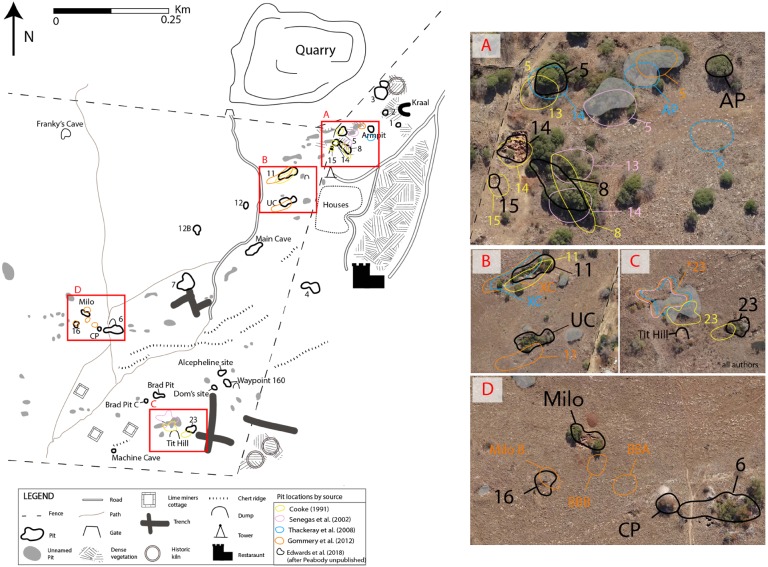
New map of Bolt’s Farm with areas of pit location error highlighted A–D.Colours represent errors by source. (A) Errors pit locations in the ‘Aves Cave Complex’ including Pit5, 8, 13, 14, 15, Arm Pit. (B) Errors in location of Pit 11 and U Cave. (C) Misidentification of Pit 23 (D) Misidentification of Pit 16 as new site Milo B and errors in the location of BBA and BBB